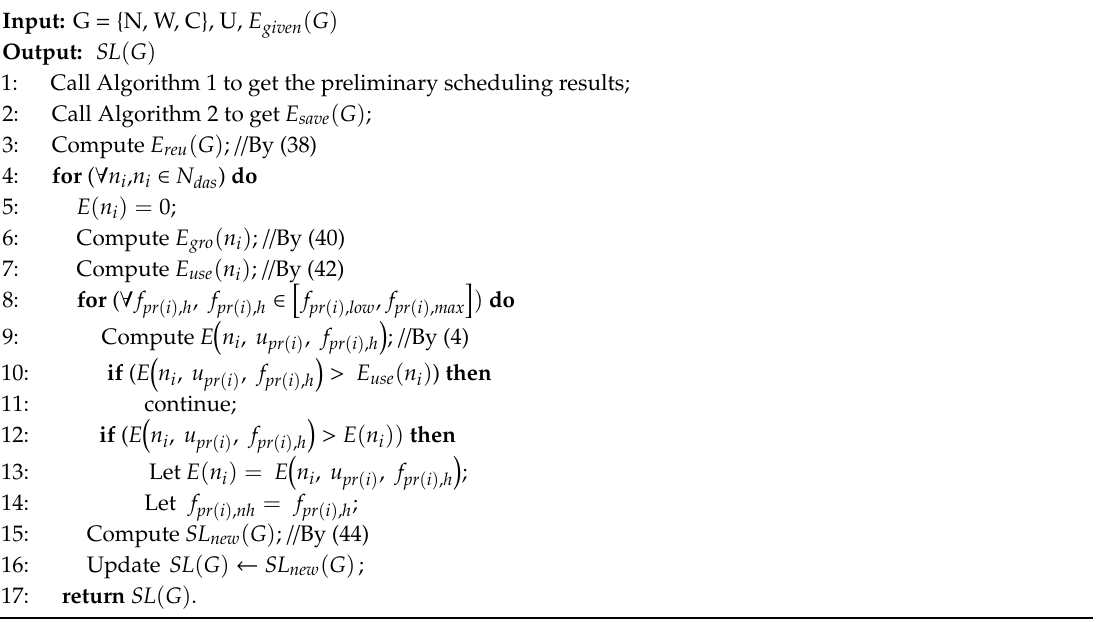
Algorithm 3. The task execution frequency re-adjustment